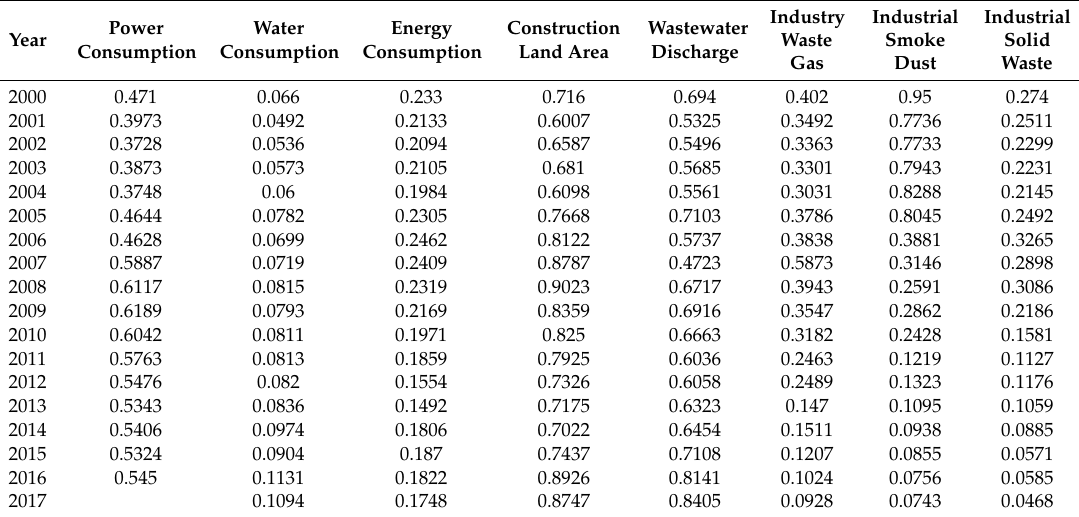
Table 4. Result of indicator data processing.